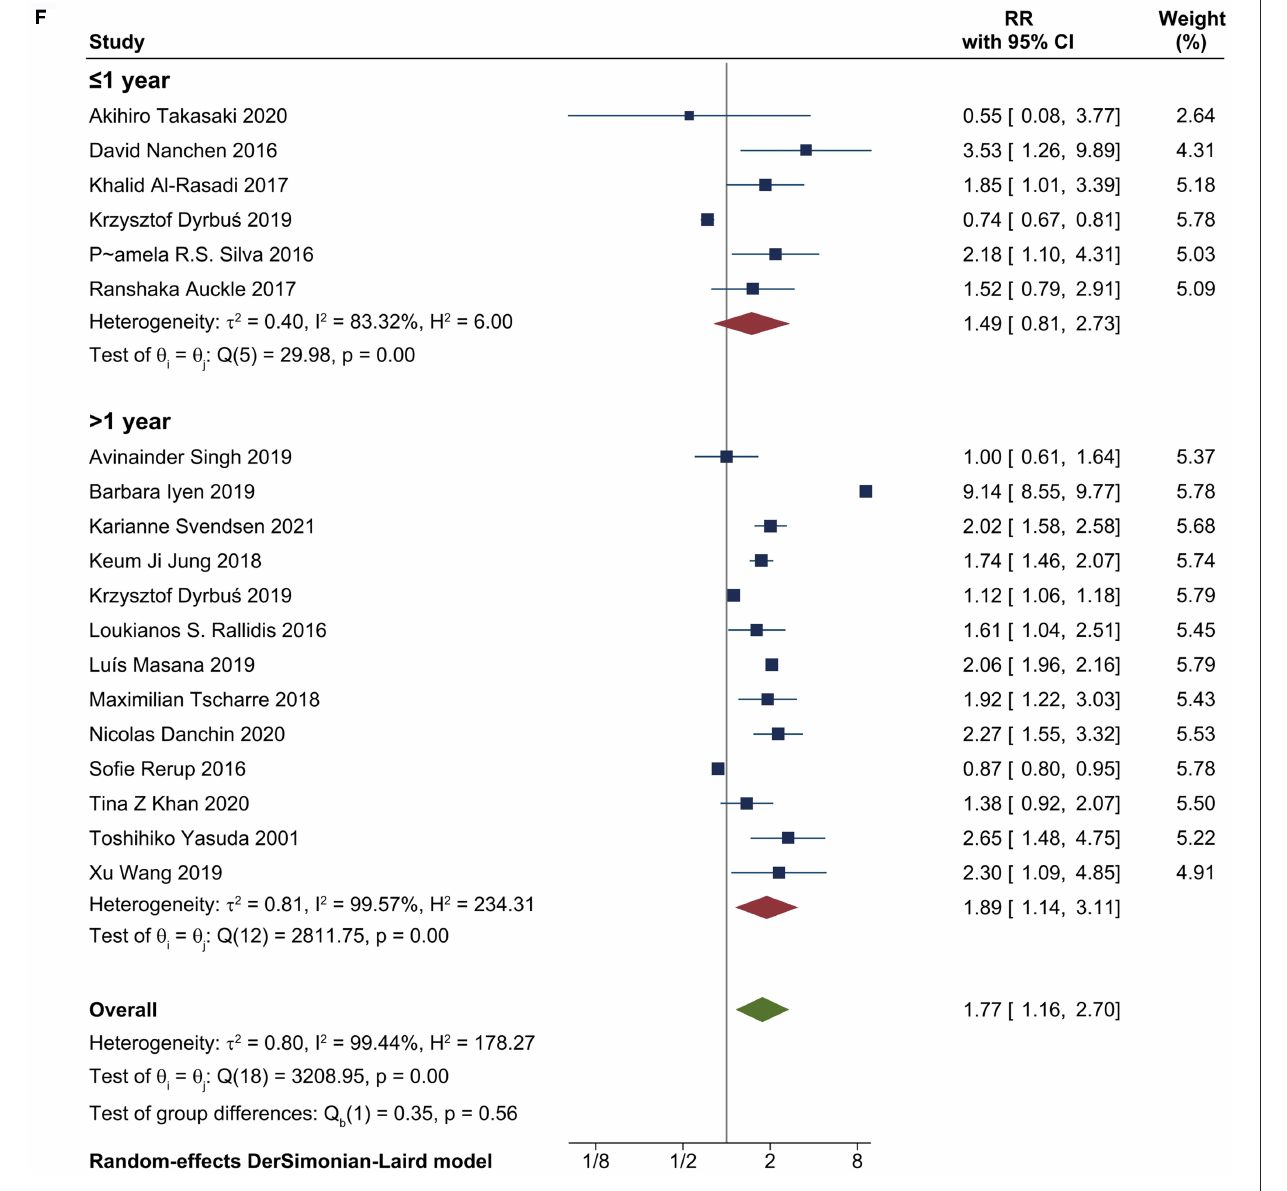
of non-adjusted time factors was 1.53 (95% CI 1.11–2.12) ( Figure 2B ). RR for CVE was 2.14 (95% CI 1.26–3.64), all cause of death 1.12 (95% CI 0.89–1.41), cardiac death 1.03 (95% CI 0.59–1.79), and overall RR 1.63 (95% CI 1.12–2.38) ( Figure 2C ). The overall pooled RR of CVE and death in ACS patients with FH was 1.71 (95% CI 1.19–2.46) ( Figure 3A ). Similarly, the risk of ACS with FH increased after adjustment for time (HR = 1.86, 95% CI 1.36–2.54); the RR of non-adjusted time factors was 1.48 (95% CI 0.83–2.64) ( Figure 3B ). RR of CVE was 1.91